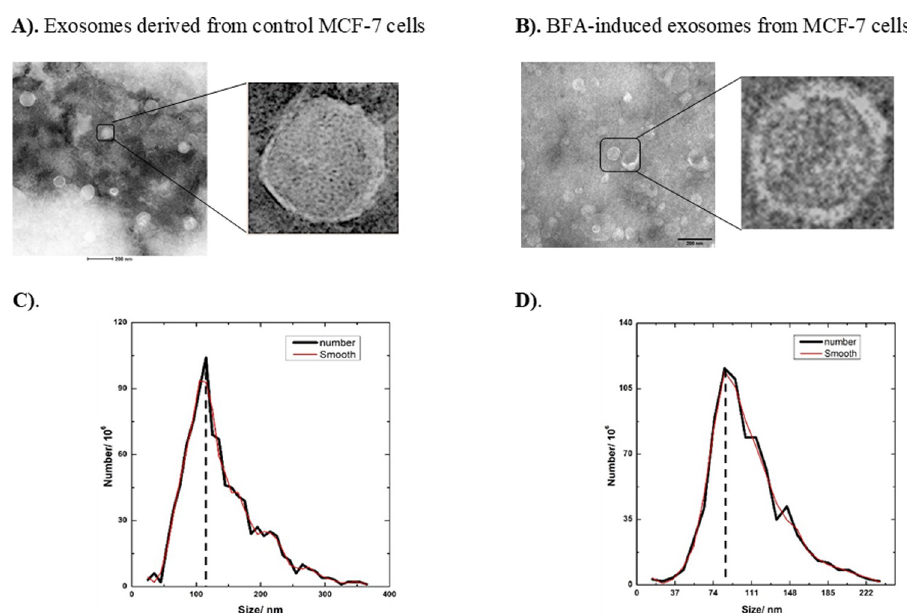
Fig 8. Characterization of exosomes: TEM micrographs of heterogeneous exosomes isolated from A). Control MCF-7 cells, and B). MCF-7 cells treated with BFA (10 μ g/mL) inhibitor for 24hr. Scale bar: 200nm C). Nanoparticle tracking analysis of isolated exosomes. The distribution peaks around ~120 nm, following the exosome enrichment during preparation. D). An uninterrupted secretion of smaller exosomes, distribution peaks around ~95 nm, were reported in the presence of a BFA (10 μ g/mL) inhibitor for 24hr. 1% Uranyl Acetate for 15sec at RT was used to stain the samples negatively.